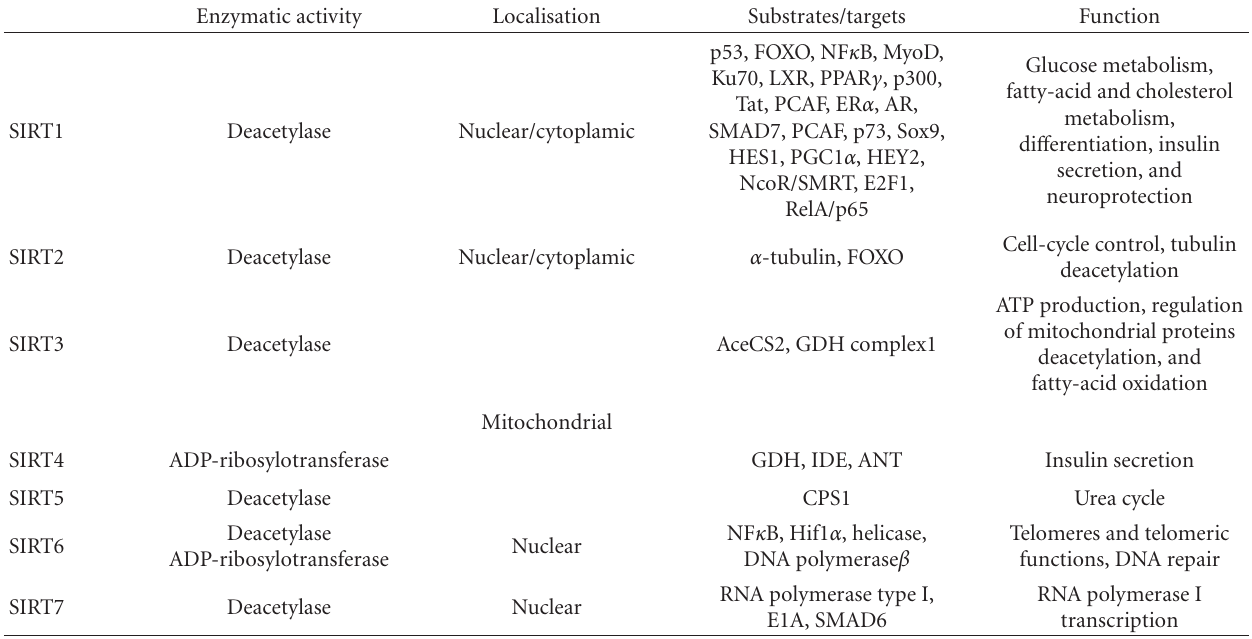
Table 1: The mammalian